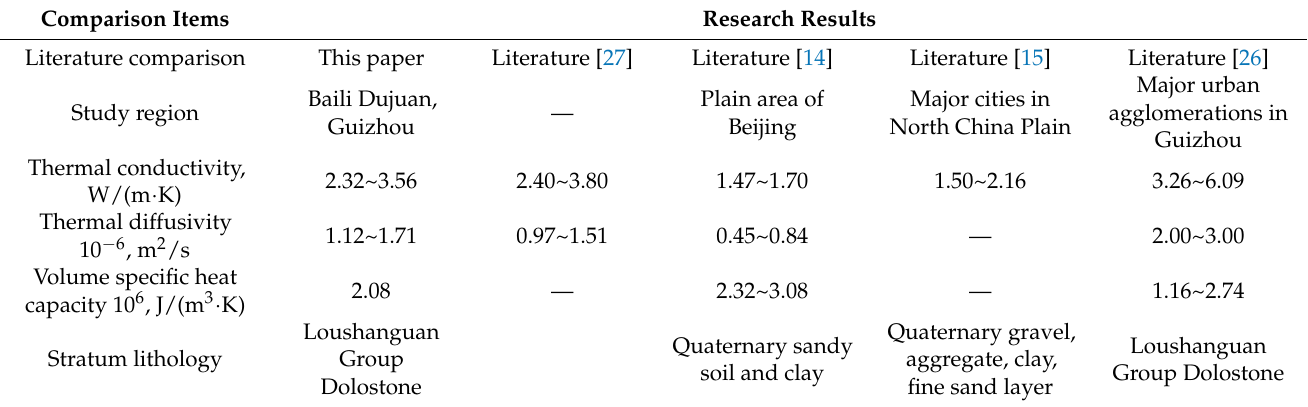
Table 4. A comparison of thermal response test